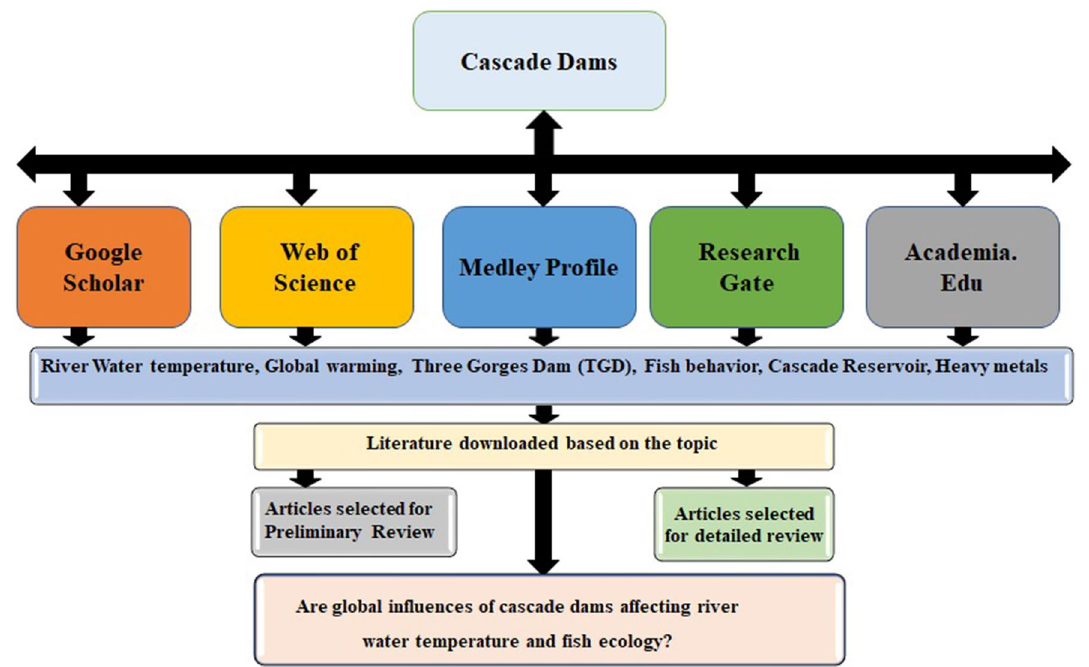
Fig. 1 Methodology for selecting the